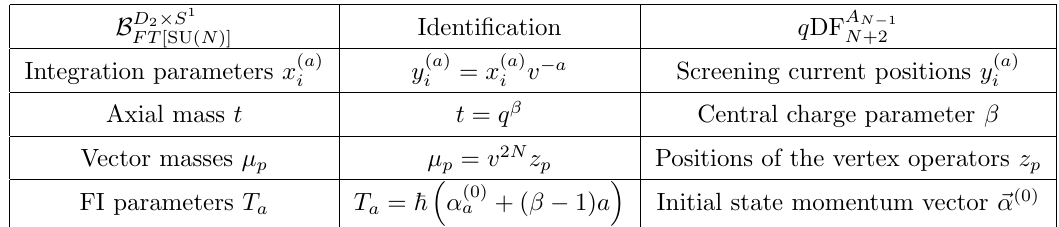
Table 1 . Map between the parameter of the FT [SU( N )] holomorphic block (2.1) and the conformal block (2.58) of the q -Toda